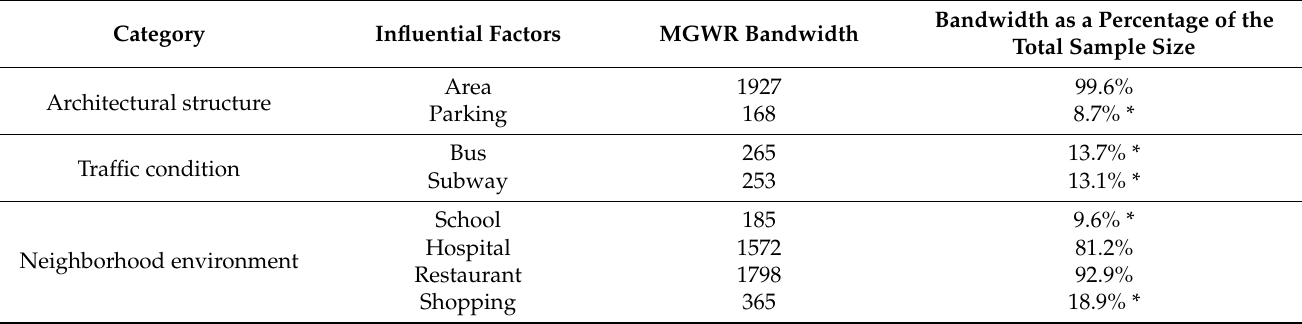
Table 8. Optimal bandwidth for each influencing factor obtained from MGWR.